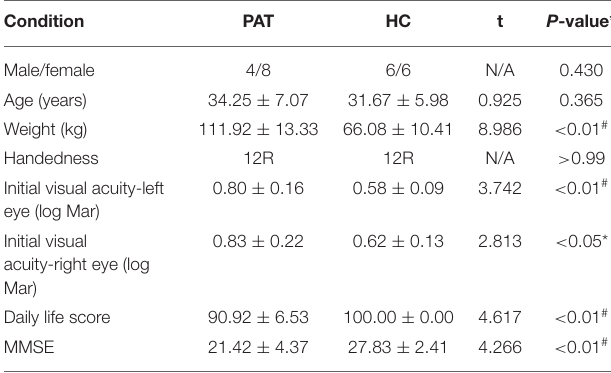
TABLE 1 | Basic Information of participants in the